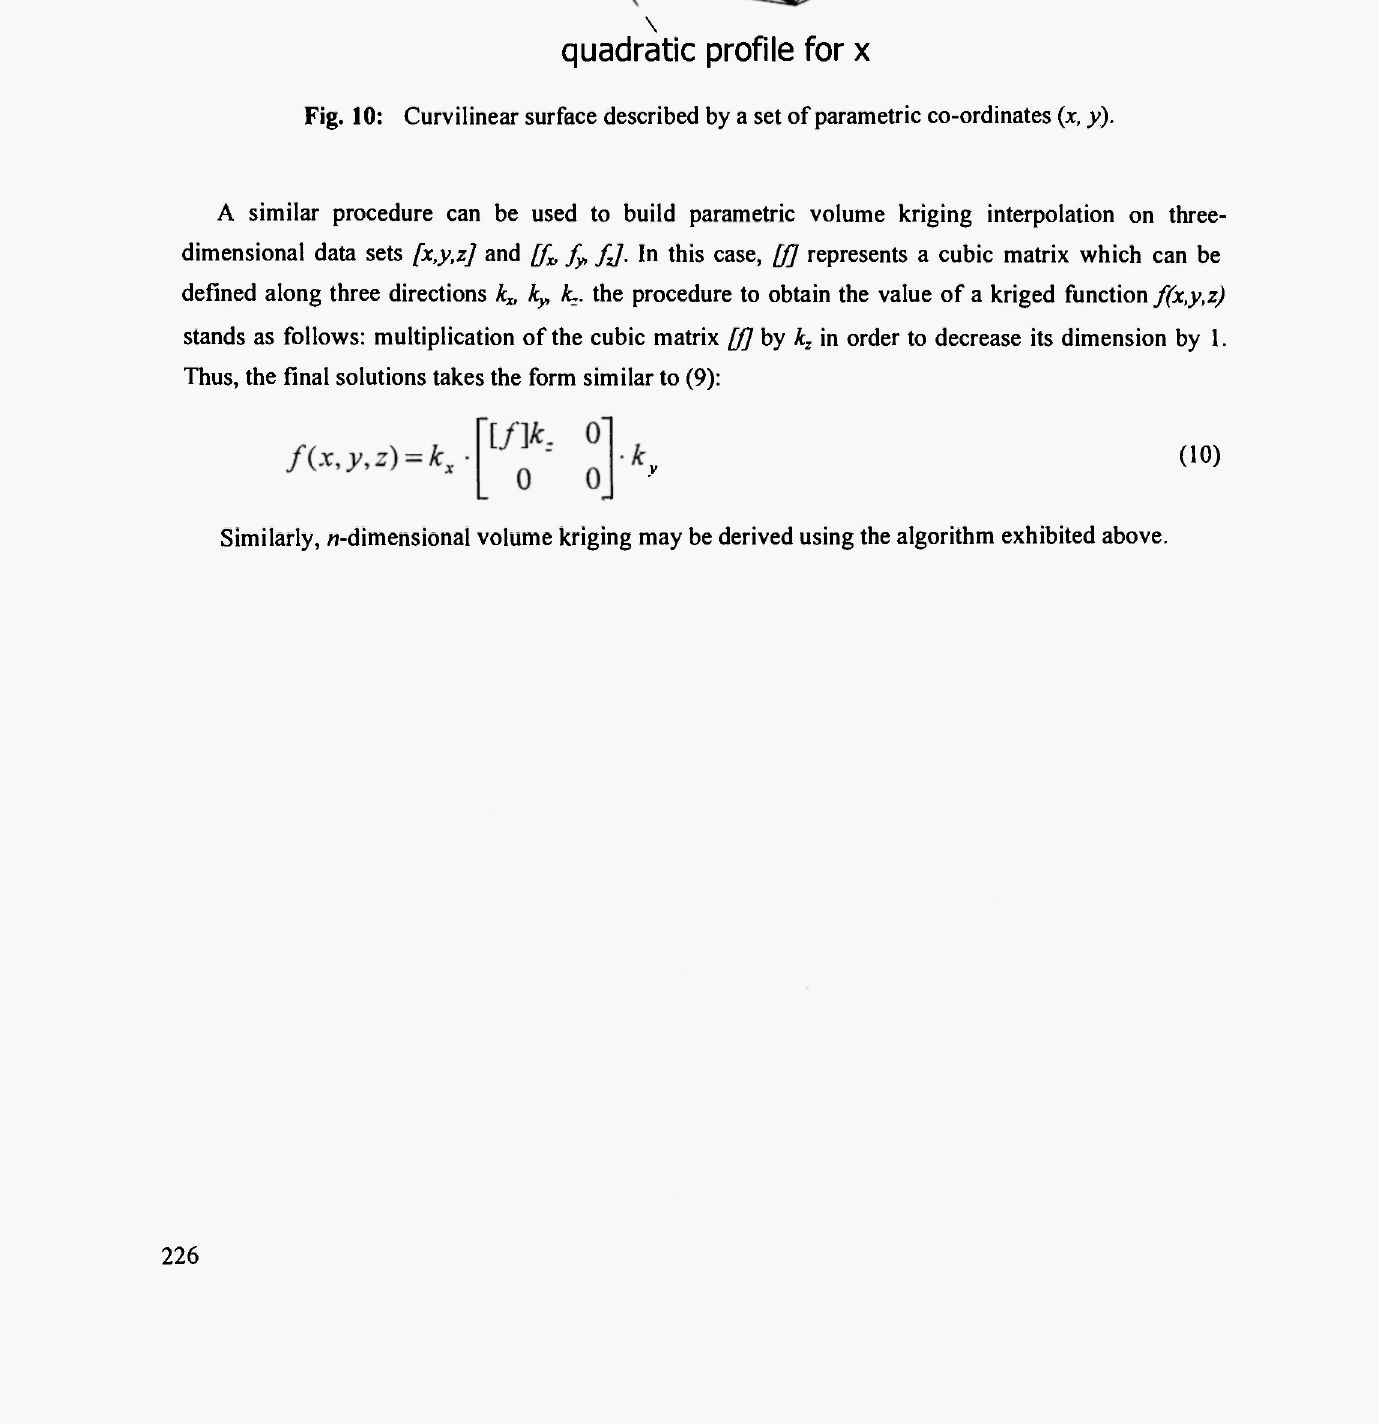
Fig. 10: Curvilinear surface described by a set of parametric co-ordinates ( χ, y).